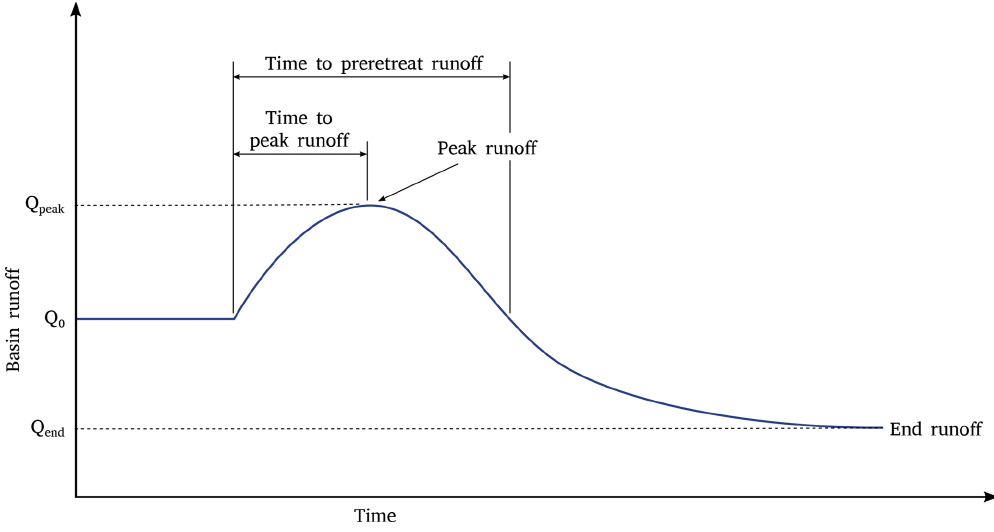
Figure 1. Conceptual model of Jansson et al. (2003) and Moore et al. (2009) that hypothesizes that, in response to climate warming, basin runoff will undergo a transient increase due to loss of glacier storage and a subsequent decrease past preretreat levels due to decreased glacier volume contribution and increased basin evapotranspiration.